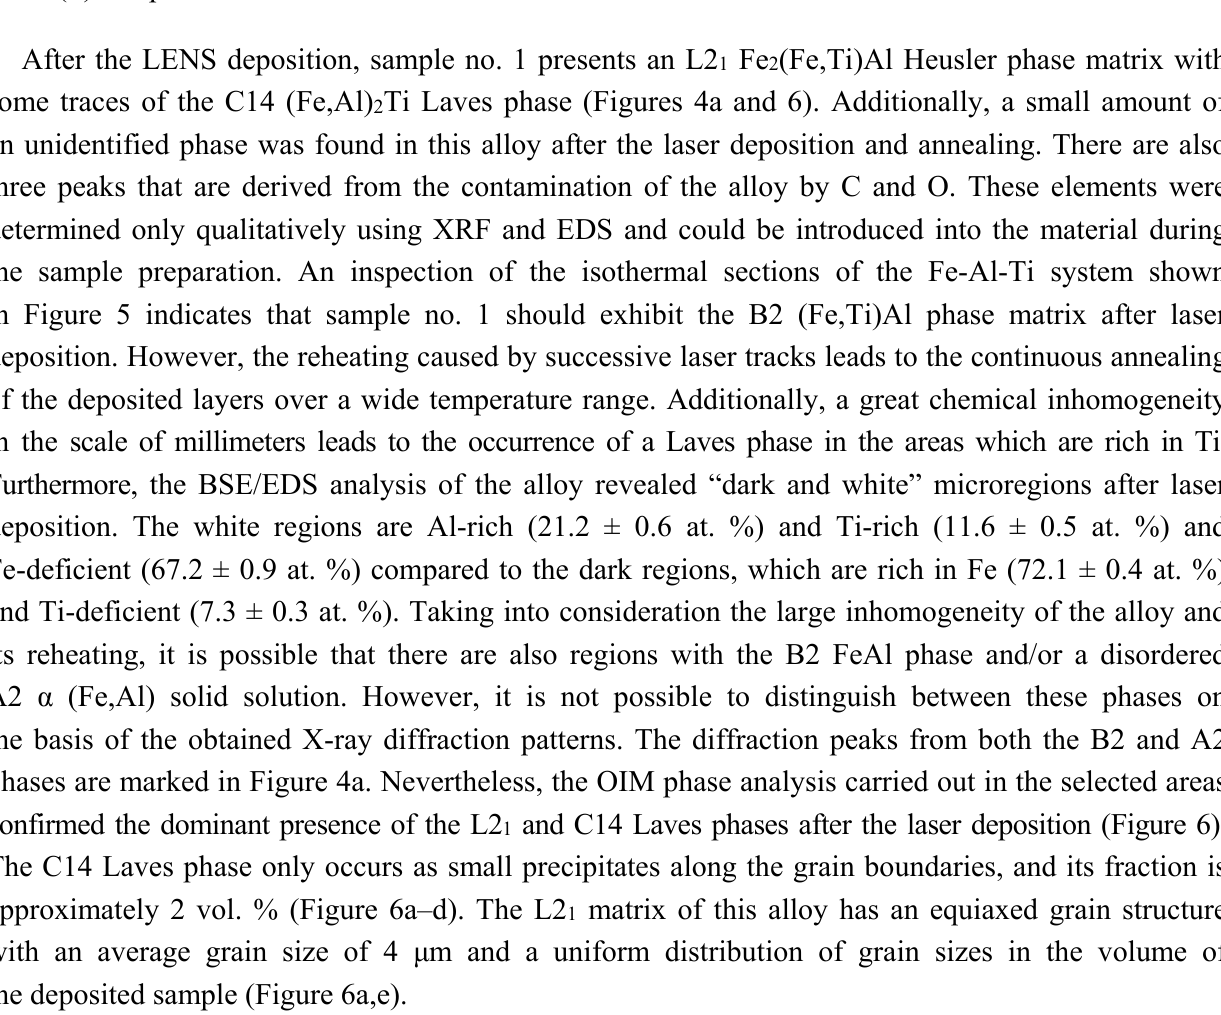
Figure 4. XRD patterns of the investigated alloys after laser deposition and annealing at 1000 °C for 20 h with furnace cooling: ( a ) sample no. 1; ( b ) sample no. 2; ( c ) sample no. 3; ( d ) sample no.